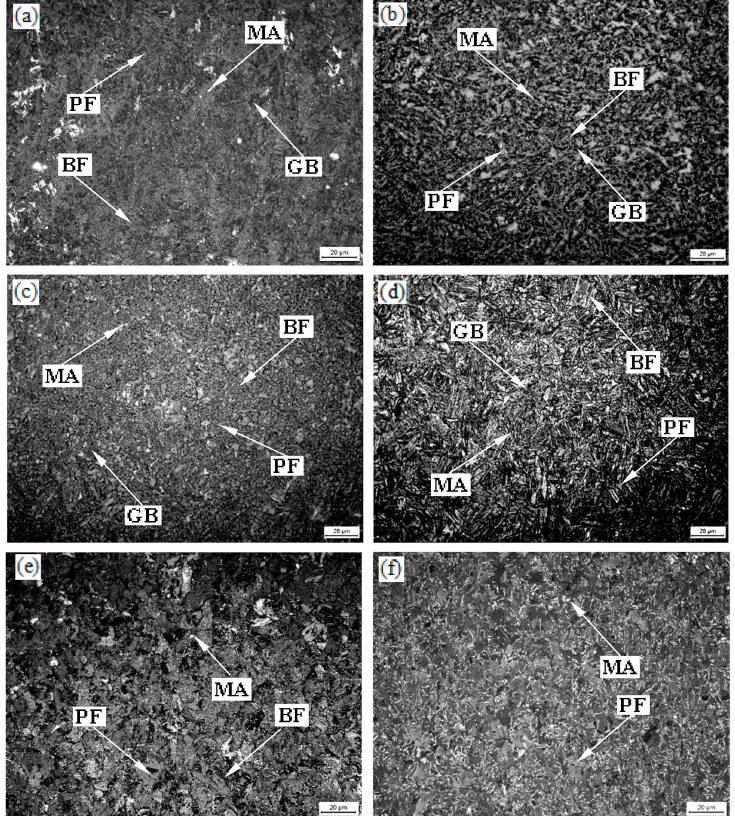
Figure 6. Optical micrographs of the experimental steel (by LePera etched) held at ( a ) 550 ◦ C; ( b ) 600 ◦ C;